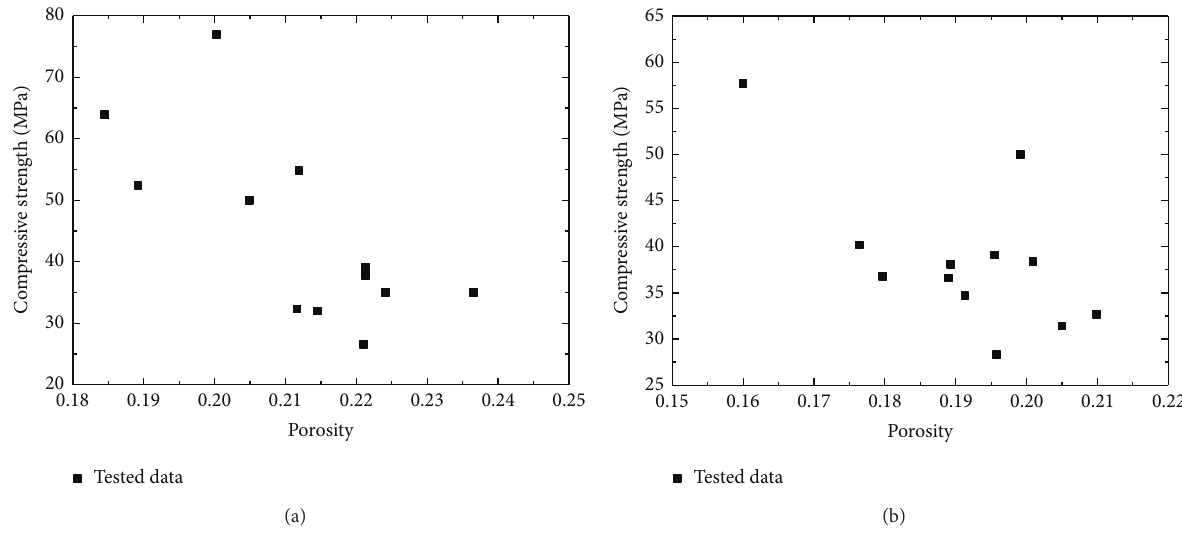
Figure 8: Compressive strength versus porosity of cement mortar: (a) manufactured sand and (b) natural sand.